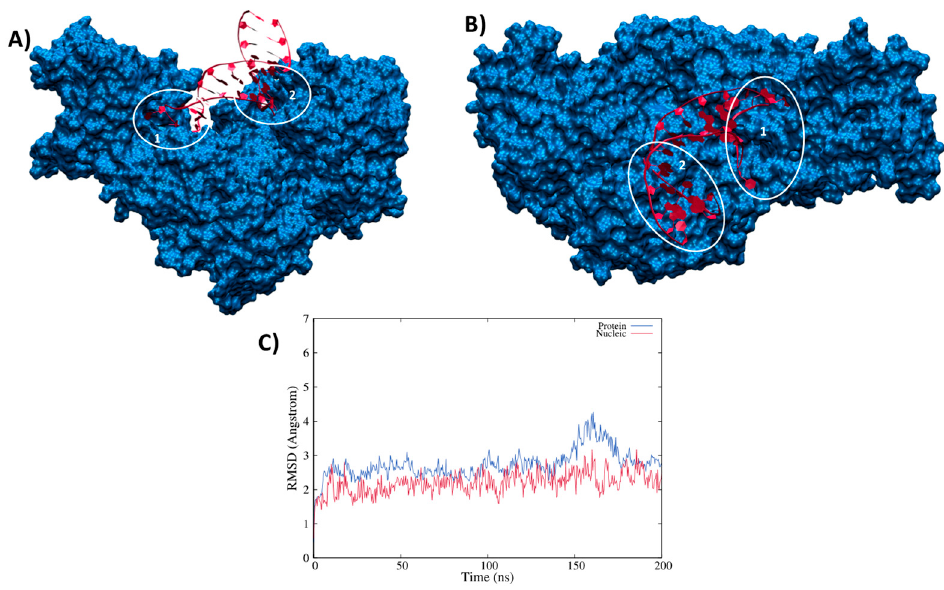
Figure 2. Side ( A ) and top ( B ) view of a representative snapshot of the MD simulation. The two main contact points involving the loop (1) or the edge (2) regions are highlighted in white circles and the time series of the RMSD for the protein (blue) and nucleic acid (red) is given in panel ( C ).